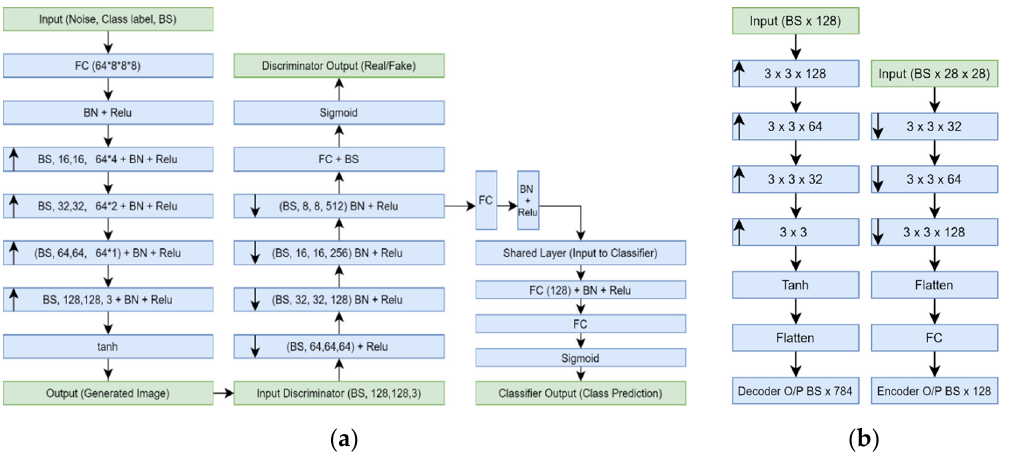
Figure 3. ↑ , ↓ , BS, FC, BN, and O/P indicate upsampling, downsampling batch size, fully connected layer, batch normalization, and output, respectively. ( a ) The architecture of Generative adversarial networks used in this study. ( b ) Variational autoencoder architecture.